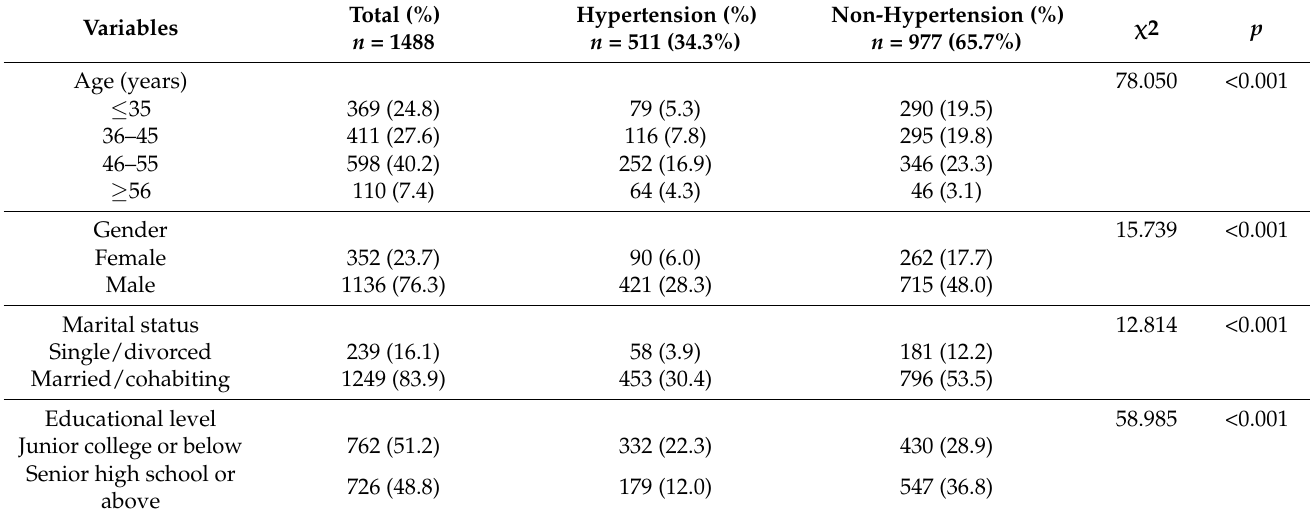
Table 1. Characteristics of the classified